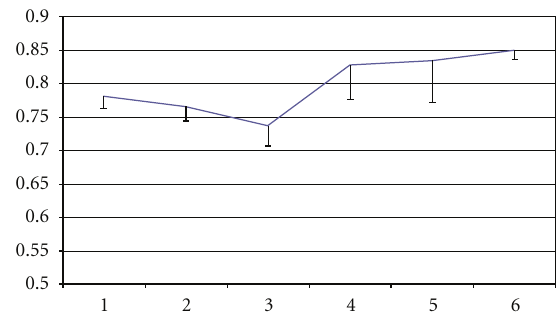
Figure 1: PET 3.86% D/P creatinine means by time (years on PD) estimated by repeated measurements mixed model analysis ( P = NS).